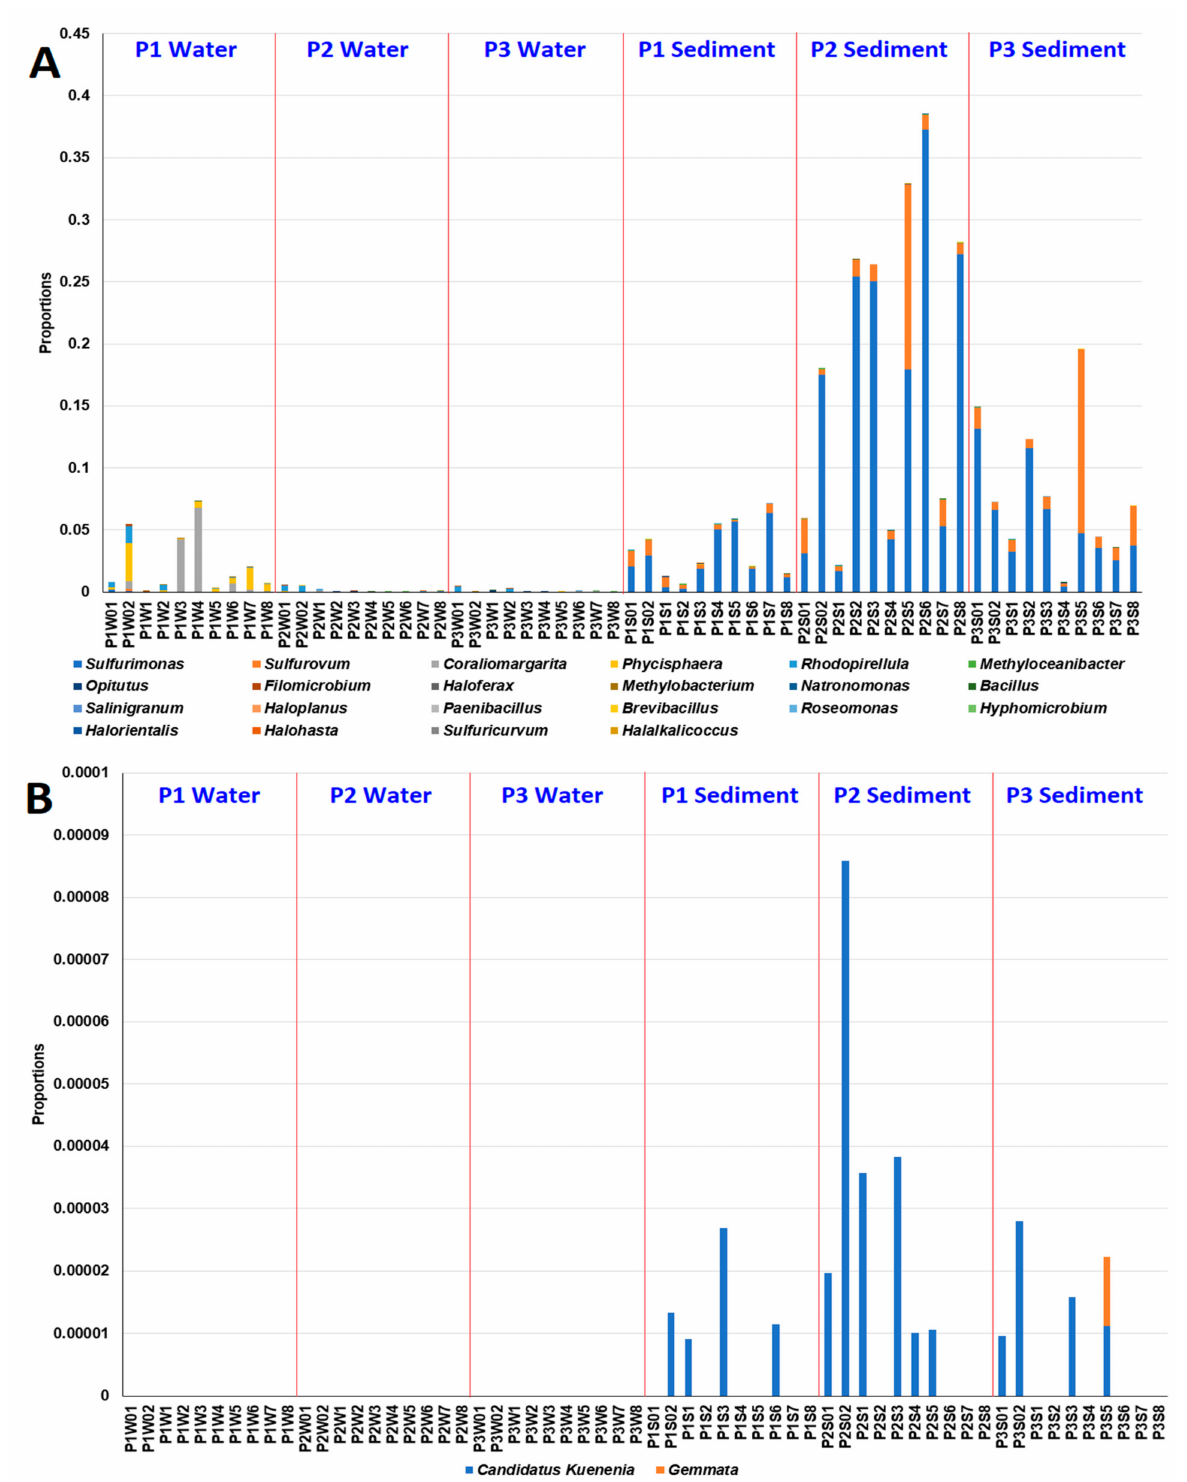
Figure 5. Proportions of assimilatory nitrate reduction (nitrate => ammonia) ( A ) and anammox (ammonia => nitrogen) ( B ) associated microbial communities among the water and sediment of small milkfish ponds. P1: control small milkfish pond. P2: small milkfish pond with the addition of MG. P3: small milkfish pond with the addition of MG and MG- degrading